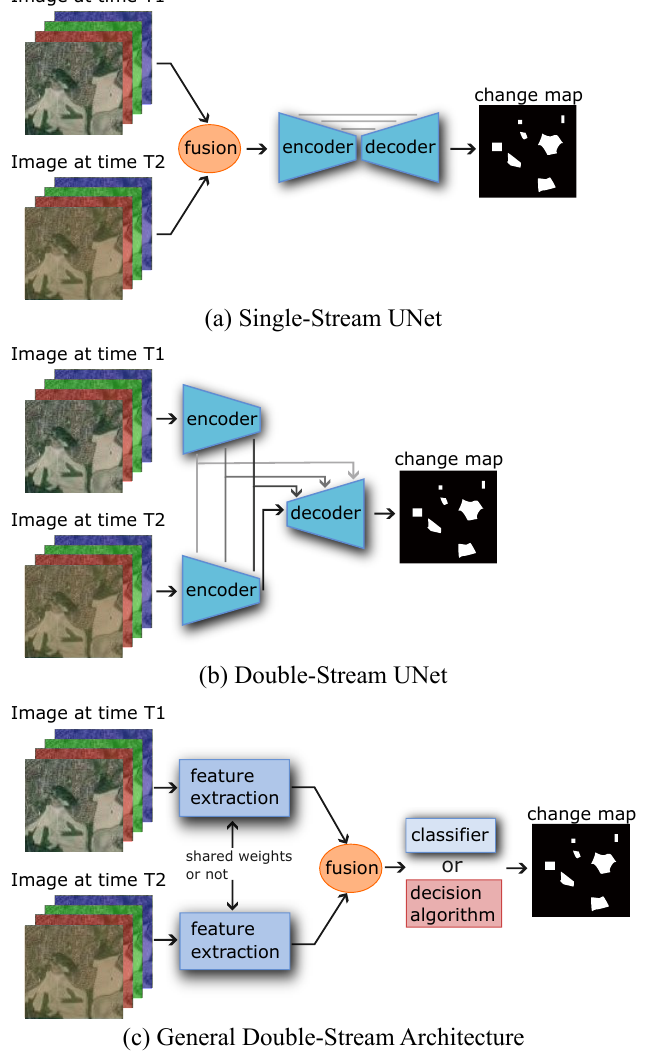
Figure 3. Structures of supervised CD models. ( a ) Single-Stream UNet-like network. The image data from two time points is first fused together, usually by concatenation, and then input into a UNet-like network featuring an encoder, a decoder and skip connections for semantic segmentation. The output of the model is a change map. ( b ) Double-Stream UNet. Each images is input separately into the encoder. The output of the two encoders is fused on multiple levels and fed to a single decoder, which produces a change map. ( c ) General Siamese Feature Extraction-based network structure. The individual images are first input into two identical Siamese (shared-weights) or pseudo-Siamese (different weights) subnetworks for feature extractions. The extracted features are then fused together, and either an automatic decision model or a machine-learning-based classifier is then used to produce a change